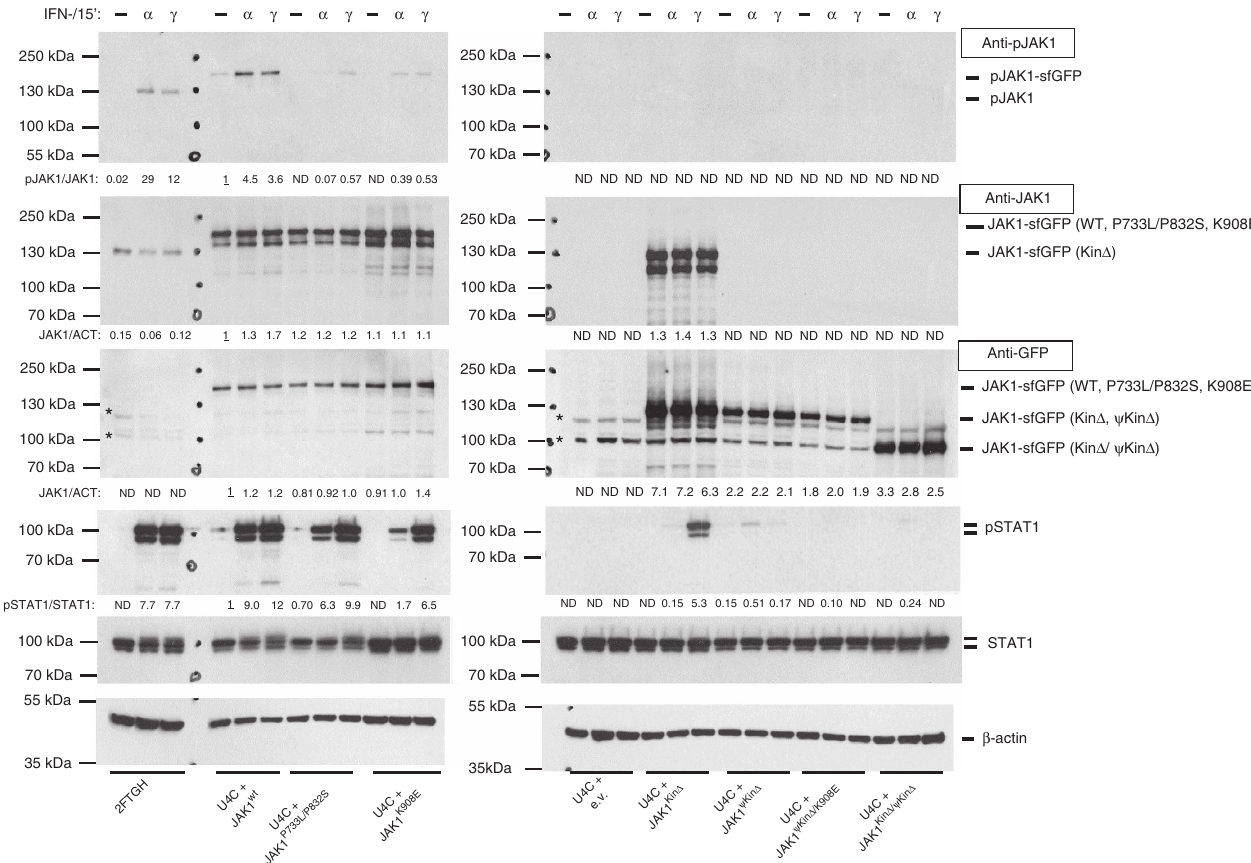
Figure 8 | JAK1 pseudokinase domain is required for mediating IFN- c signalling. Stable clones of the JAK1-deficient Flp-In U4C fibrosarcoma cells, expressing JAK1 WT , JAK1 P733L/P832S , JAK1 K908E , JAK1 Kin D , JAK1 C Kin D , JAK1 C Kin D /K908E or JAK1 Kin D / C Kin D were exposed to 100ng ml (cid:2) 1 IFN- a or 5ngml (cid:2) 1 of IFN- g or medium ( (cid:2) ) for 15min. Cells expressing empty vector (e.v.) and parental, JAK1-competent, fibrosarcoma cells, 2fTGH, served as negative and positive controls, respectively. *Shows non-specific protein species detected by the antibody. Note that anti-phospho-JAK1 antibody cannot be used to analyse phosphorylation of JAK1 Kin D or JAK1 Kin D / C Kin D , whereas anti-JAK1 antibody cannot detect JAK1 C Kin D , JAK1 C Kin D /K908E or JAK1 Kin D / C Kin D , which lack relevant target epitopes. Representative of at least three independent experiments. Fold change of band densitometry is indicated (numbers below bands and bar graphs in Supplementary Fig.